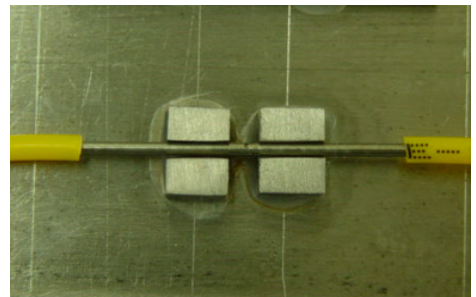
Sensors 2019 , 19 , x FOR PEER REVIEW Figure 7. The prototype of wide-range FBG sensor. Figure 7. The prototype of wide-range FBG sensor.